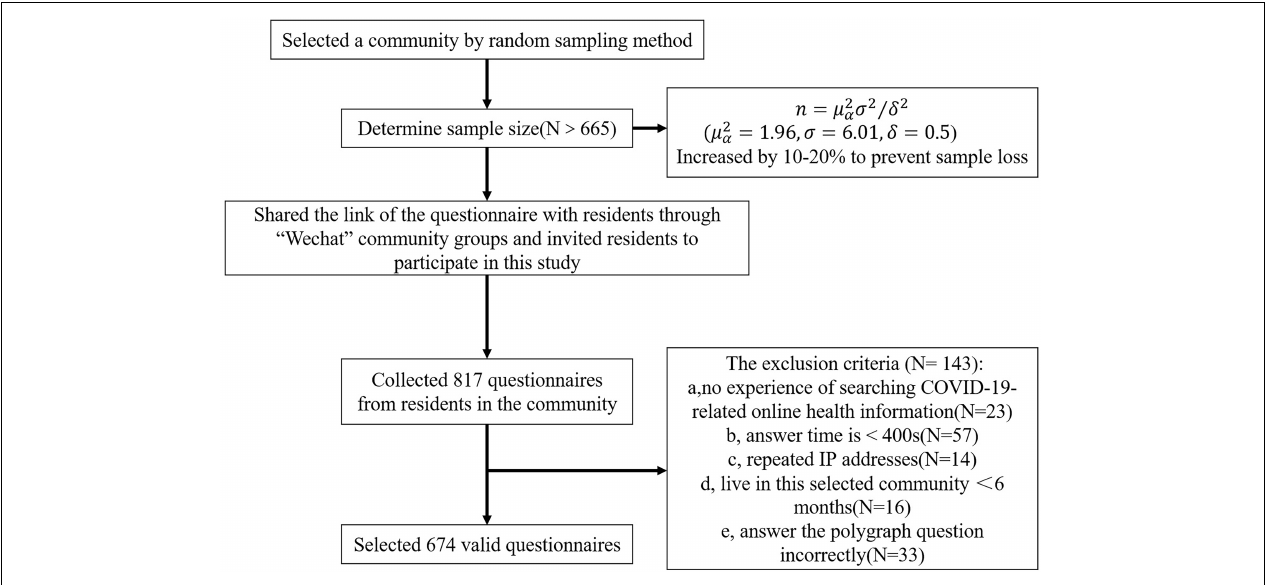
FIGURE 1 | The process of participants sampling and